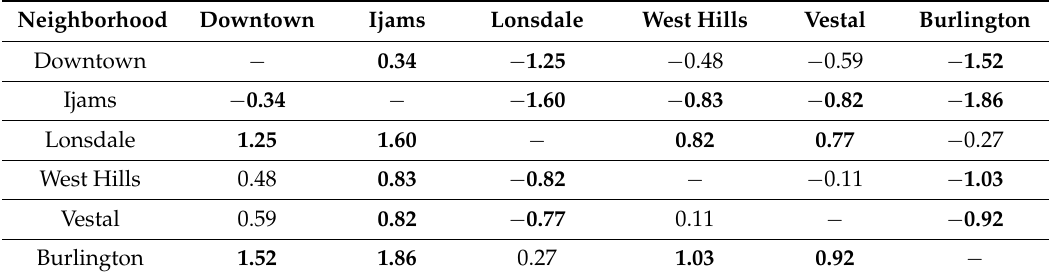
Table 4. Comparison of 1500 LDT heat index ( ˝ C) between combined data (HV and MV) for each neighborhood and control locations (Downtown and Ijams). Mean differences are shown. Bolded numbers indicate significant results ( p < 0.05). Negative numbers indicate the column neighborhood is lower than the row neighborhood